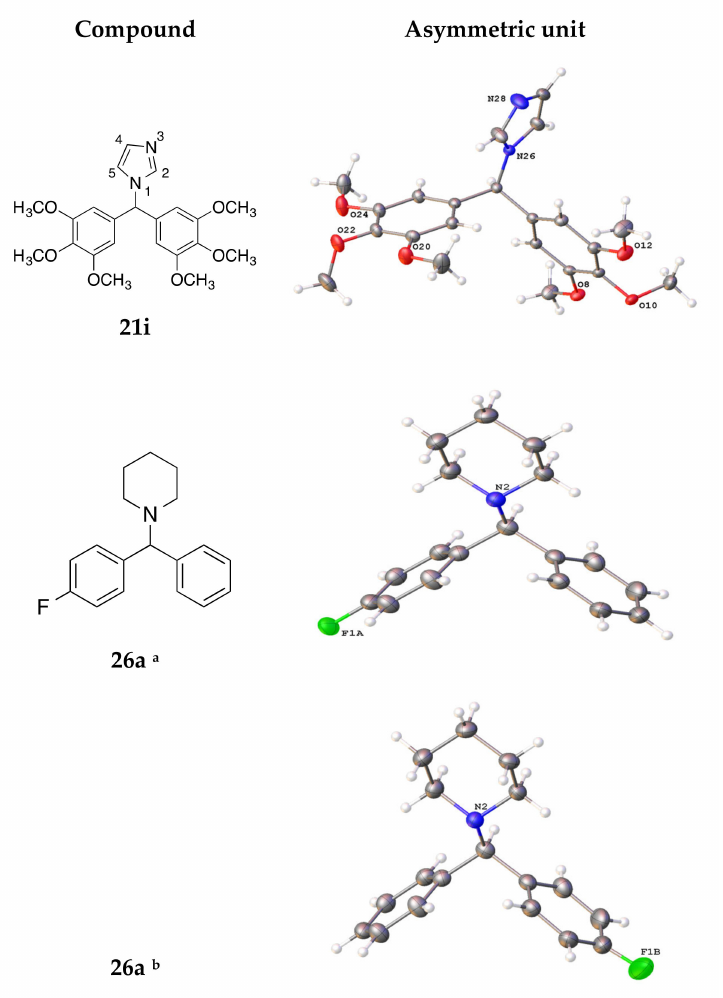
Figure 3. X-ray crystallography of compounds 21i and 26a with heteroatoms labelled and displace- ment shown at 50% probability. a Disordered molecular structure of 26a showing the major occupied moiety F1a. b Disordered molecular structure of 26a showing the minor occupied moiety